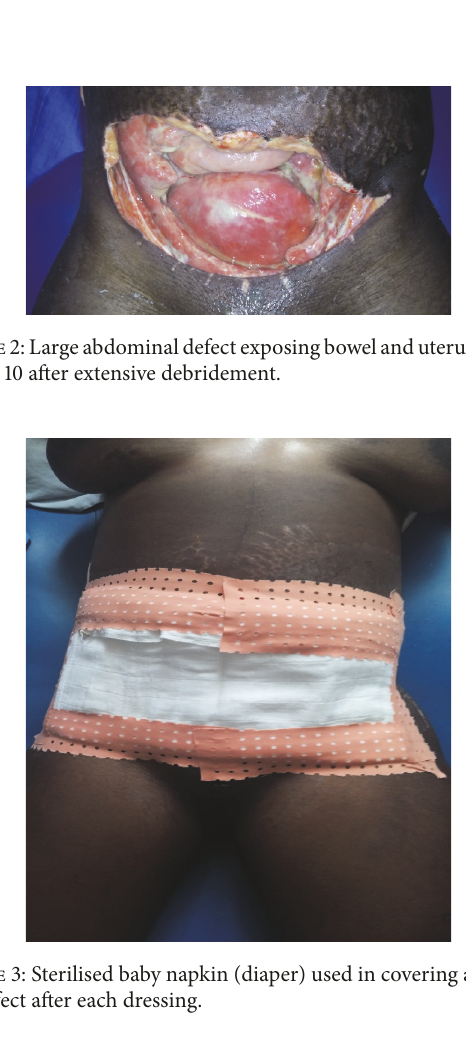
Figure 1: (a) Shows locally available baby napkin (diaper) in its original package; (b) shows some napkins placed in an autoclave; and (c) Depicts napkins undergoing the sterilisation process.